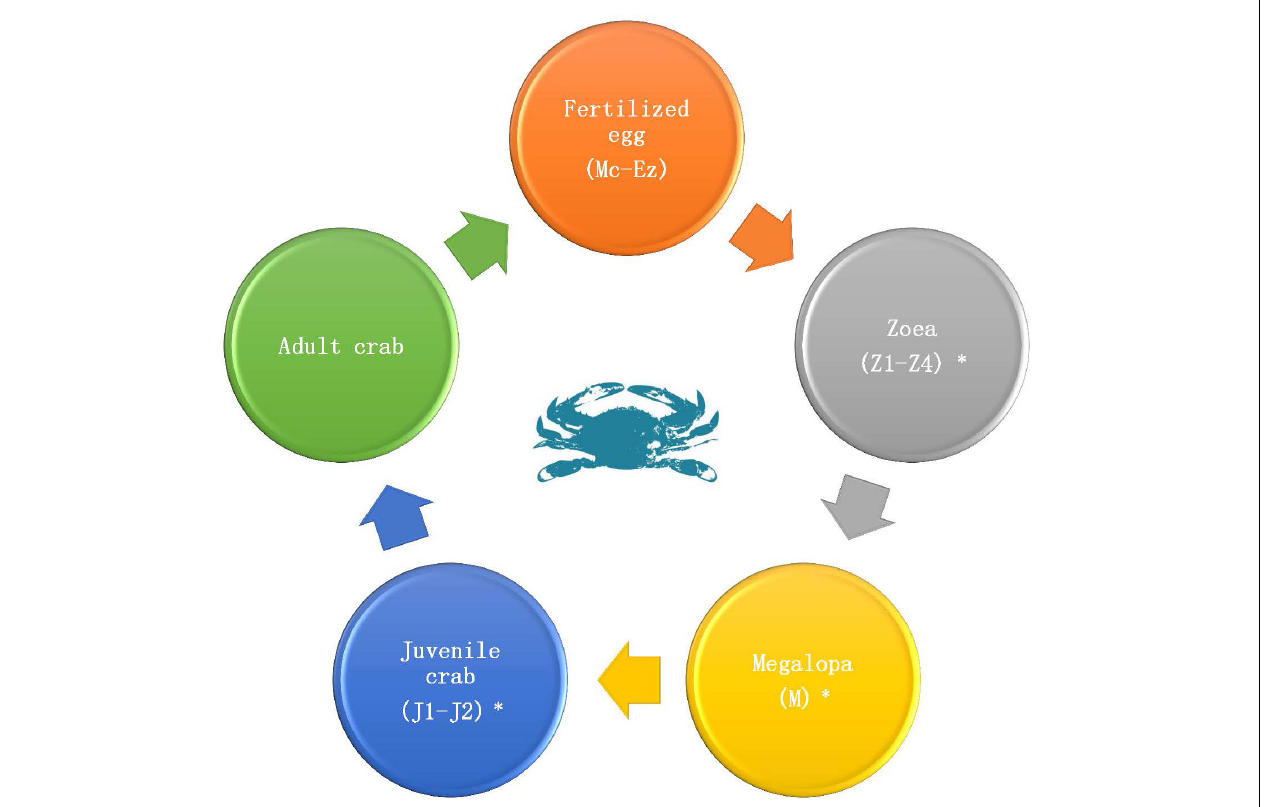
FIGURE 1 | Life cycle of P. trituberculatus . Fertilized egg (Multicellular stage, Mc; Blastula stage, B; Gastrulation stage, G; Egg-nauplius stage, En; Egg-zoea stage, Ez), Zoea (Zoea 1, Z1; Zoea 2, Z2; Zoea 3, Z3; Zoea 4, Z4), Megalopa (M), and Juvenile crab (Juvenile crab 1, J1; Juvenile crab 2, J2). The periods marked with a “ ∗ ” are the periods at which transcriptome sequencing was